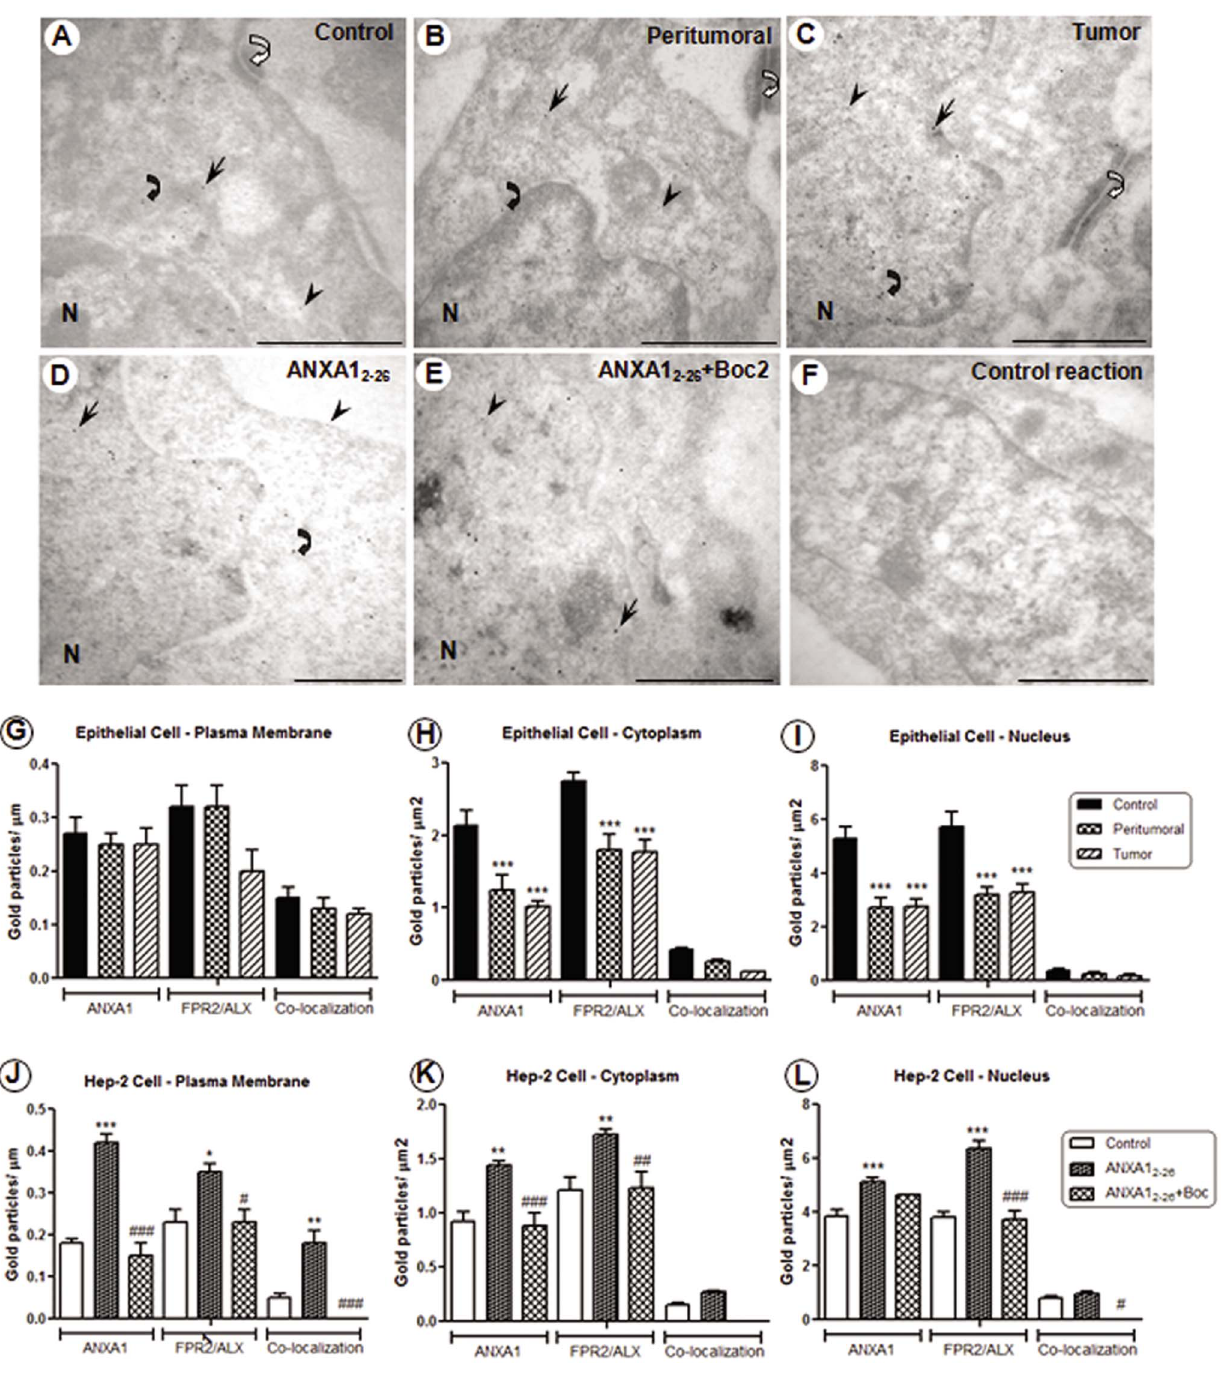
Fig. 4. Ultrastructural immunocytochemistry detection of ANXA1 and FPR2/ALX co-localization in laryngeal cells by electron microscopy. Immunolabeling with 10-nm (FPR2/ALX) and 15-nm (ANXA1) colloidal gold particles. ( A–C ) Epithelial control, peritumoral and tumor cells from laryngeal tissues. ( D–E ) Hep-2 cells showing immunoreactivity to ANXA1 (arrows), FPR2 (arrowheads), and co-localizations (curve arrows) in the plasma membrane, cytoplasm and nucleus (N). Desmosomes (open curve arrows) are detected between these cells. ( F ) The absence of immunoreactivity to ANXA1 and FPR2/ ALX in cells incubated with nonimmune serum. Density of gold particles conjugated with ANXA1 and FPR2/ALX in epithelial cells ( G–I ) and Hep-2 cells ( J– L ). Hep-2 cells were seeded in MEM-Earle medium at a density of 2 6 10 6 cells in 75-cm 2 culture flasks, and then were incubated with serum-free medium 24 hours prior to the addition of ANXA1 2–26 (1 m M) and ANXA1 2–26 (1 m M) + Boc2 (10 m M). Data are expressed as the mean ¡ SEM of colloidal gold